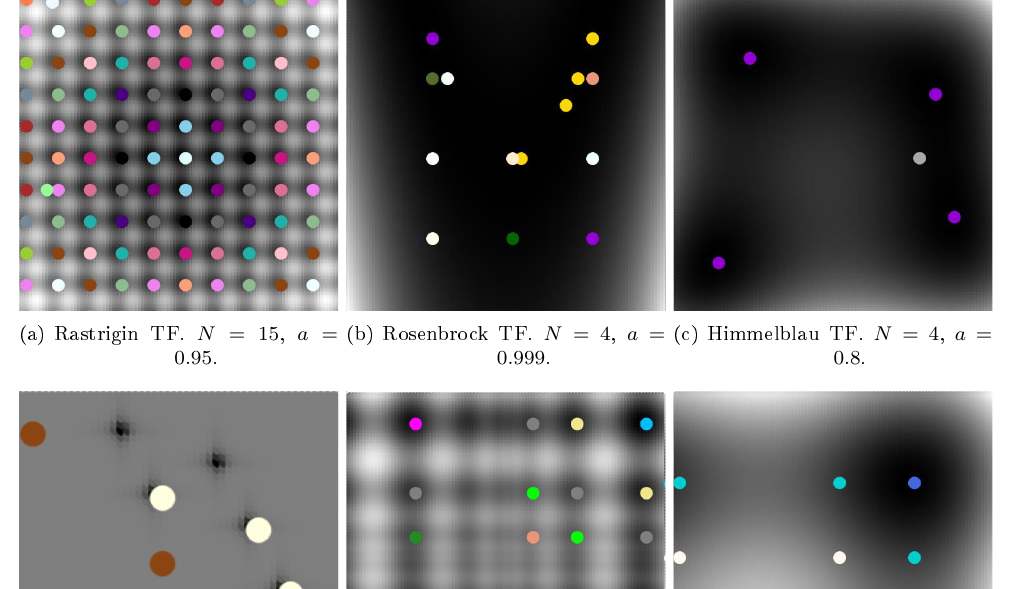
Fig. 5. Lambda TF. N =3, a =0.95. Fig. 6. Schwefel TF. N =5, a =0.85. Fig. 7. Giunta TF. N =4, a =0.85. (d) Lambda TF. N = 3 , a = 0 . 95 . (e) Schwefel TF. N = 5 , a = 0 . 85 . (f) Giunta TF. N = 4 , a = 0 . 85 .